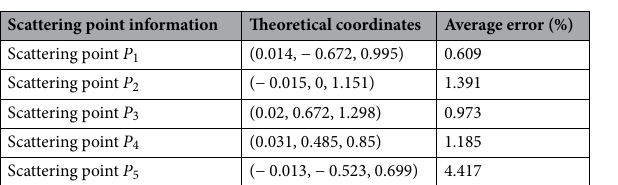
Table 3. Coordinates of each scattering point of the target.